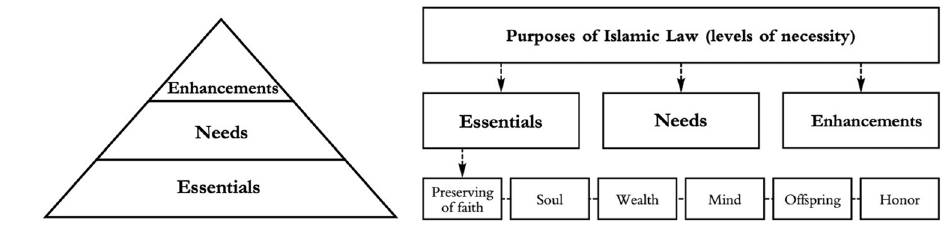
Fig. 1 Specifying the Levels of Necessity in Maqā ṣ id dis- course () adapted from